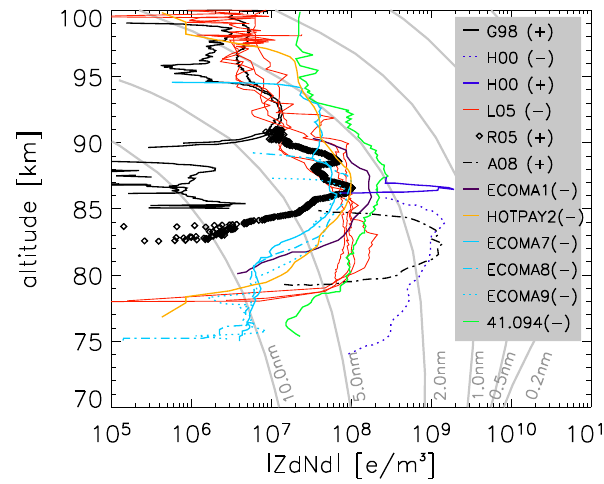
Fig. 1. Rocket-borne charged MSP density measurements during nighttime, updated from Rapp et al. (2007) and Friedrich and Rapp (2009), grey contours show MSP number densities after Hunten et al. (1980), legend entries are explained in Table 1, +/- indicate the charge sign of the measured